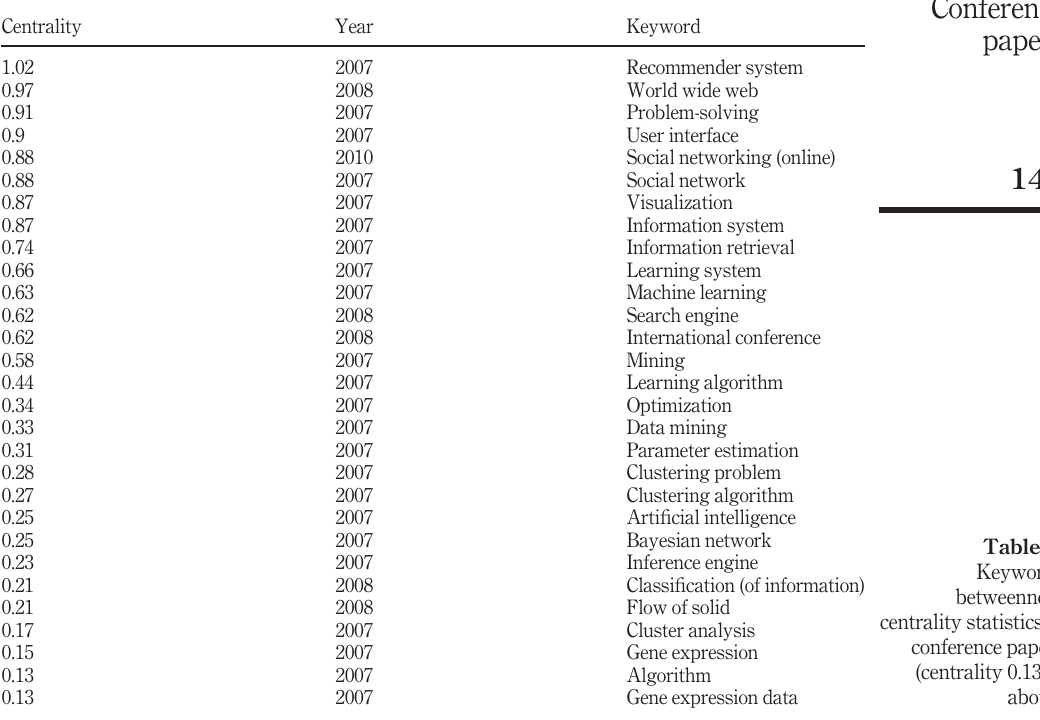
betweenness centrality statistics of conference